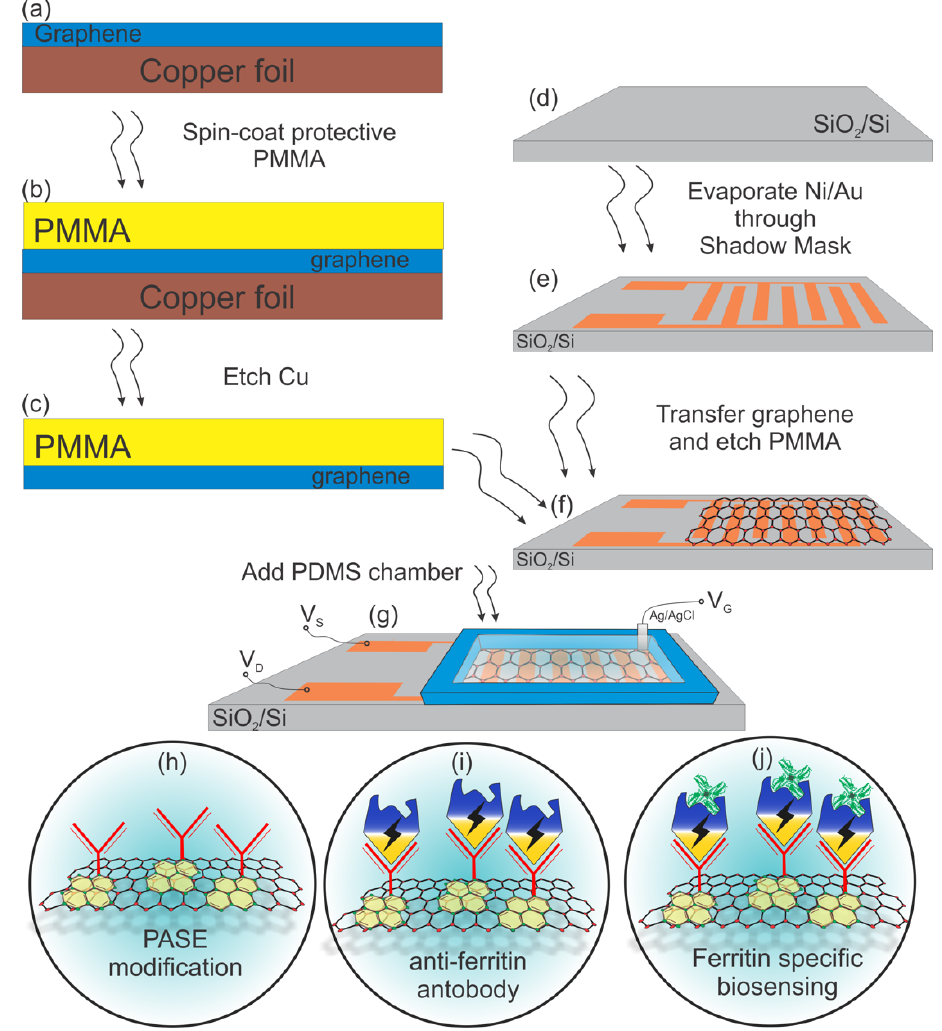
Figure 1. ( a – f ) Graphene-based field-e ff ect transistor (GFET) biosensor fabrication process; ( g ) the schematic of the final GFET-based biosensor with a polydimethylsiloxane (PDMS) well on top to secure electrolyte; ( h – j ) further graphene functionalization with pyrenebutanoic acid, succinimidyl ester (PASE), an anti-ferritin antibody and the final step of ferritin-specific